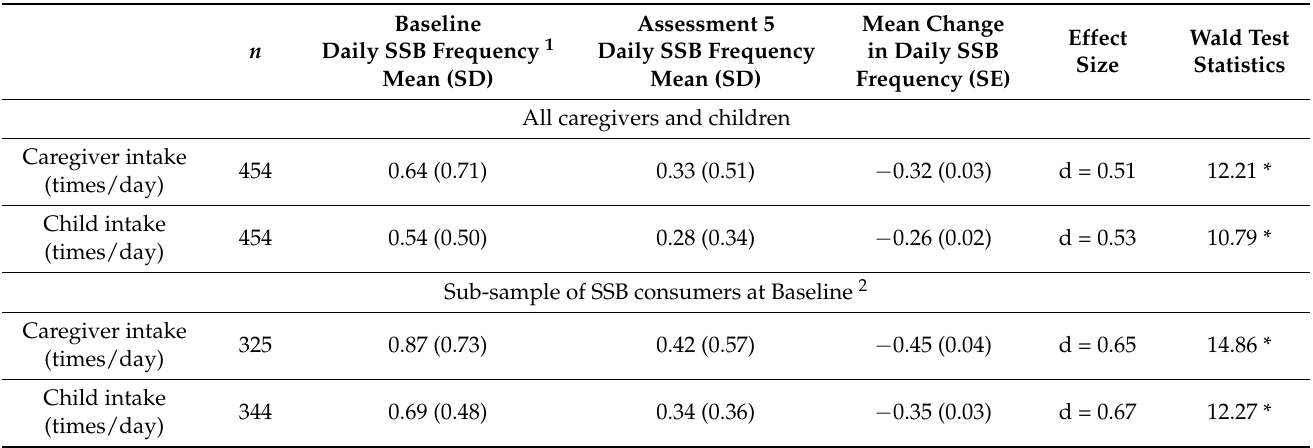
Table 2. Caregiver self-report of personal and child’s sugar-sweetened beverage (SSB) changes from Baseline to Assessment